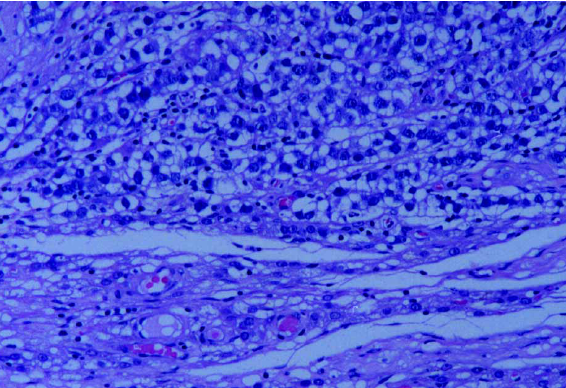
Figure 1 – Photomicrography of right testicle tumor, showing classical seminoma with invasion of the “rete testis” (HE,